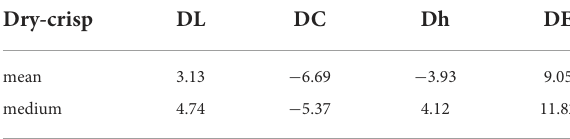
TABLE 1 The difference between the crisp and dry colour centres. TABLE 2 Compilation of crisp and dry ratings (mean ±